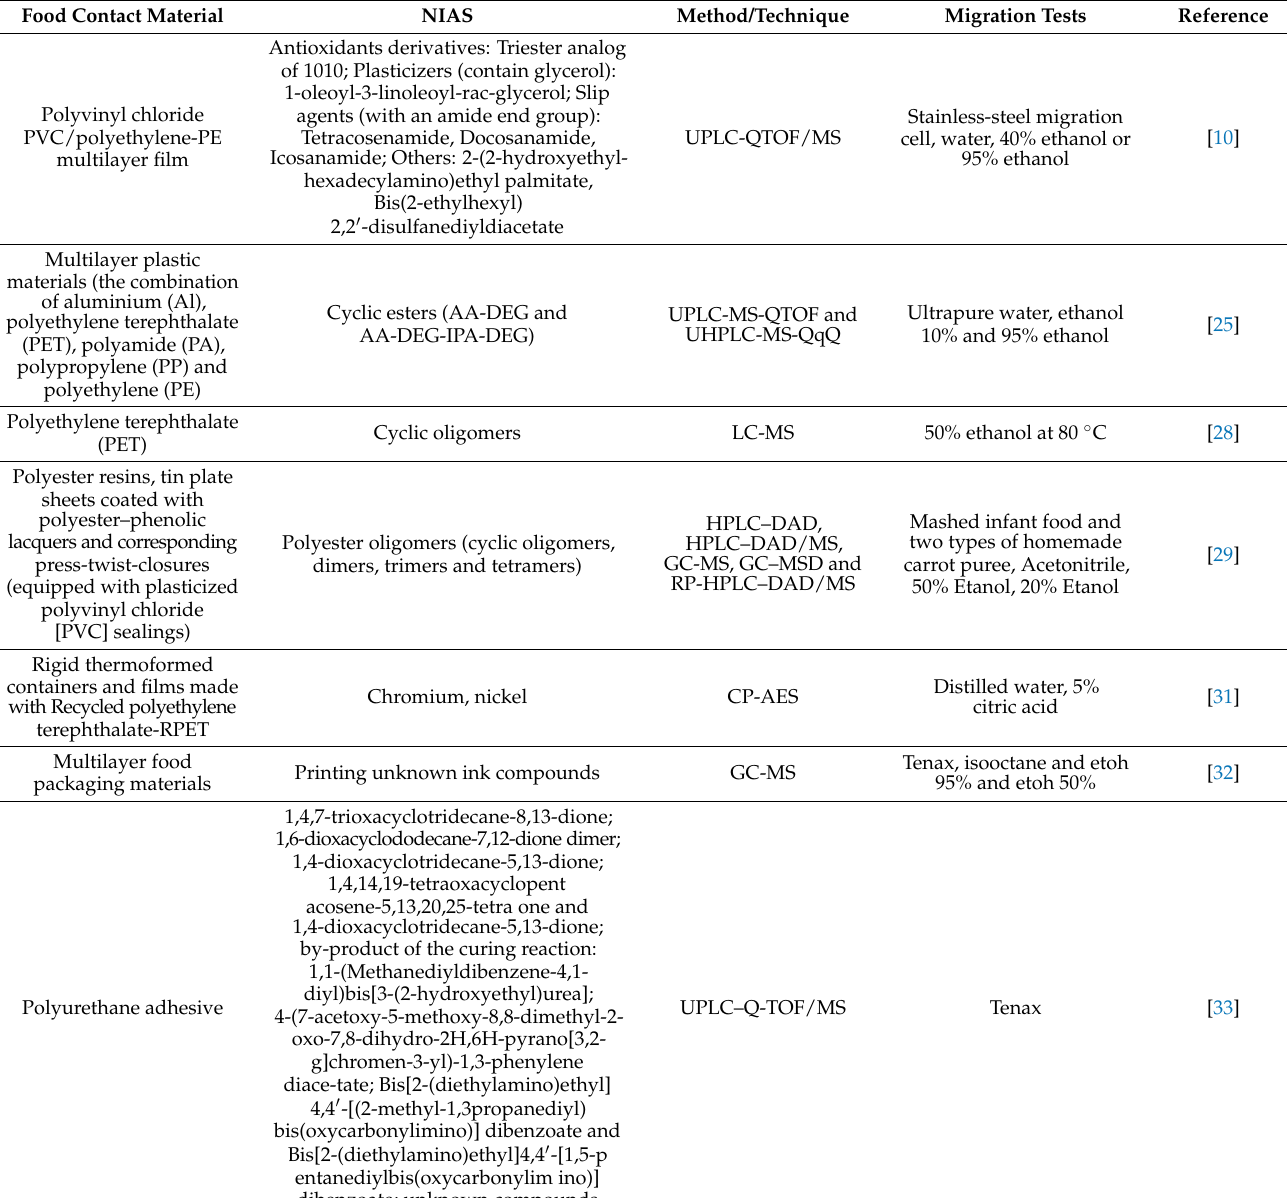
Table 1. Studies published in the literature on NIAS Identification in different plastic food